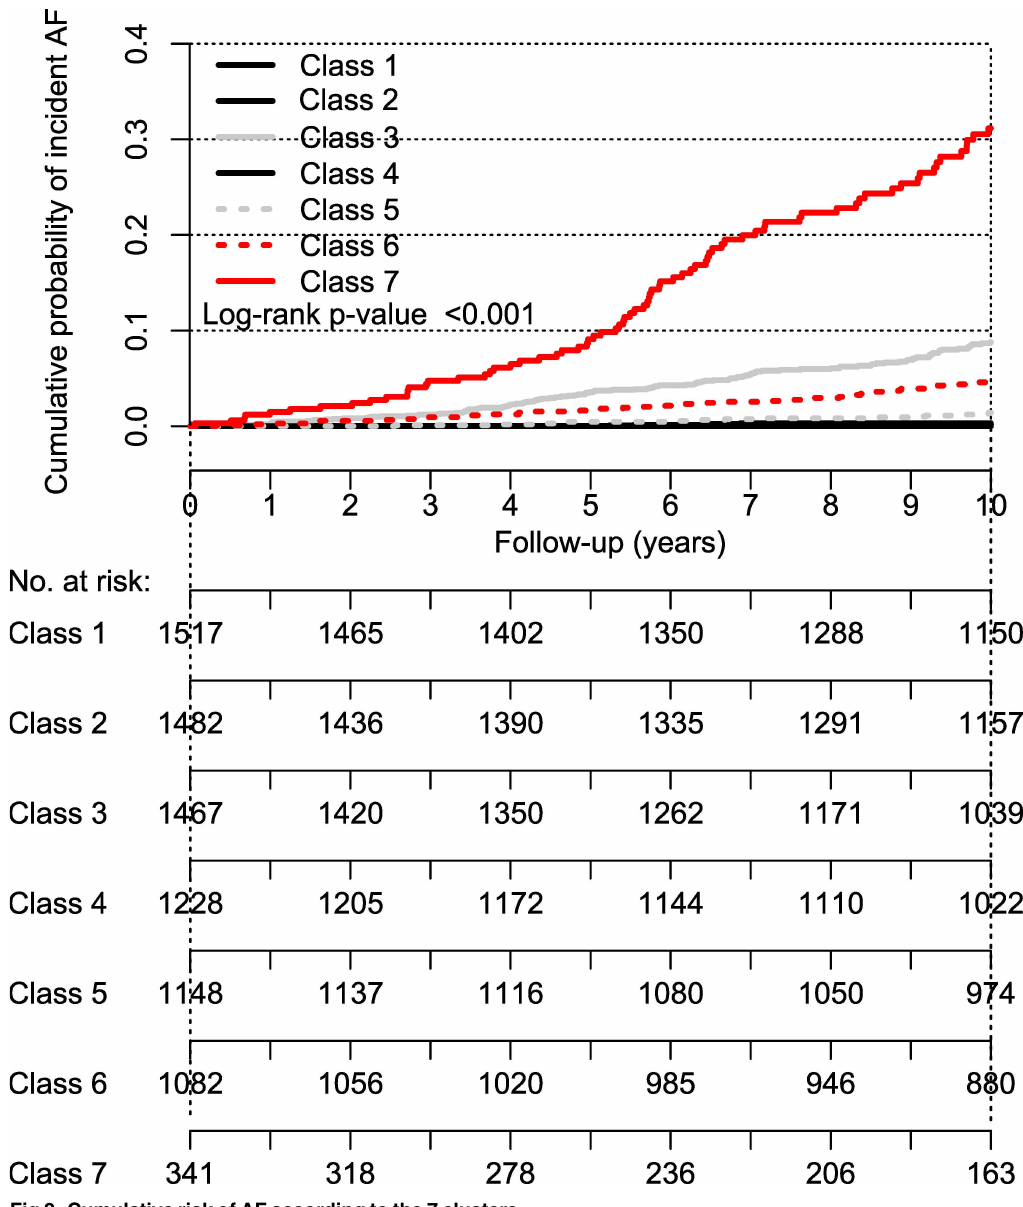
Fig 2. Cumulative risk of AF according to the 7